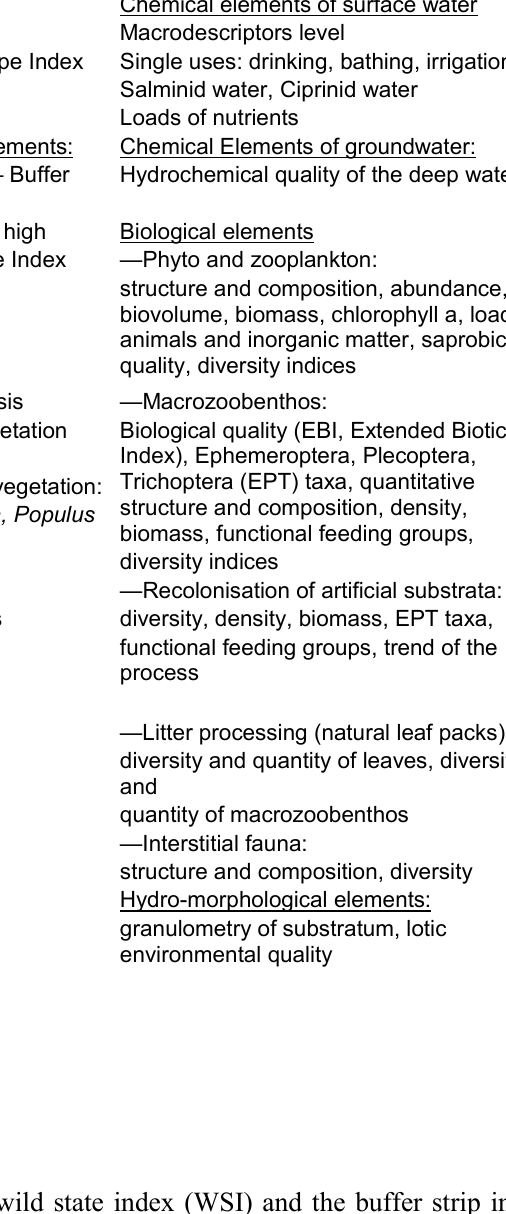
List of the Analyses Achieved Divided According to the Ecosystem Compartments and Components